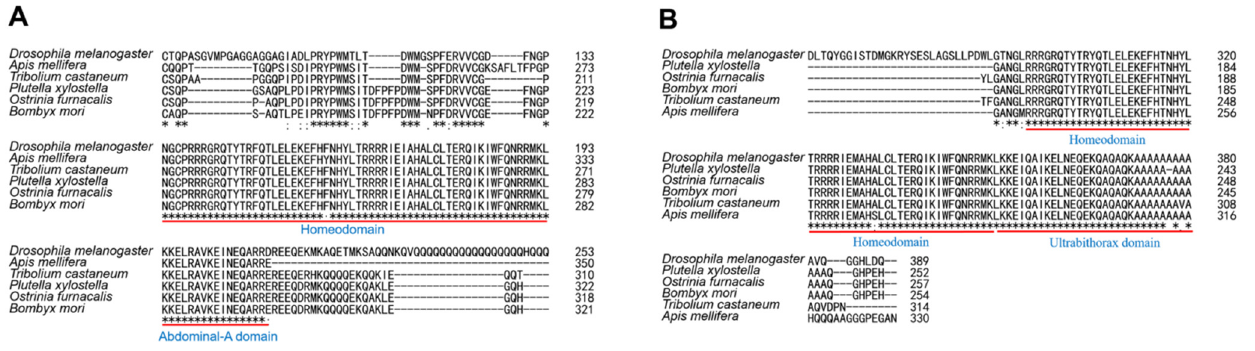
Figure 2. Sequence alignment of Abd-A and Ubx proteins. ( A ) Abd-A and ( B ) Ubx proteins were aligned from six insects, including previously reported sequences from D. melanogaster , A. mellifera , T. castaneum , P. xylostella , B. mori , and our newly identified sequences from O. furnacalis . Alignments of Abd-A and Ubx have common Homeodomain and specific conserved Abdominal-A and Ultrabithorax domains.